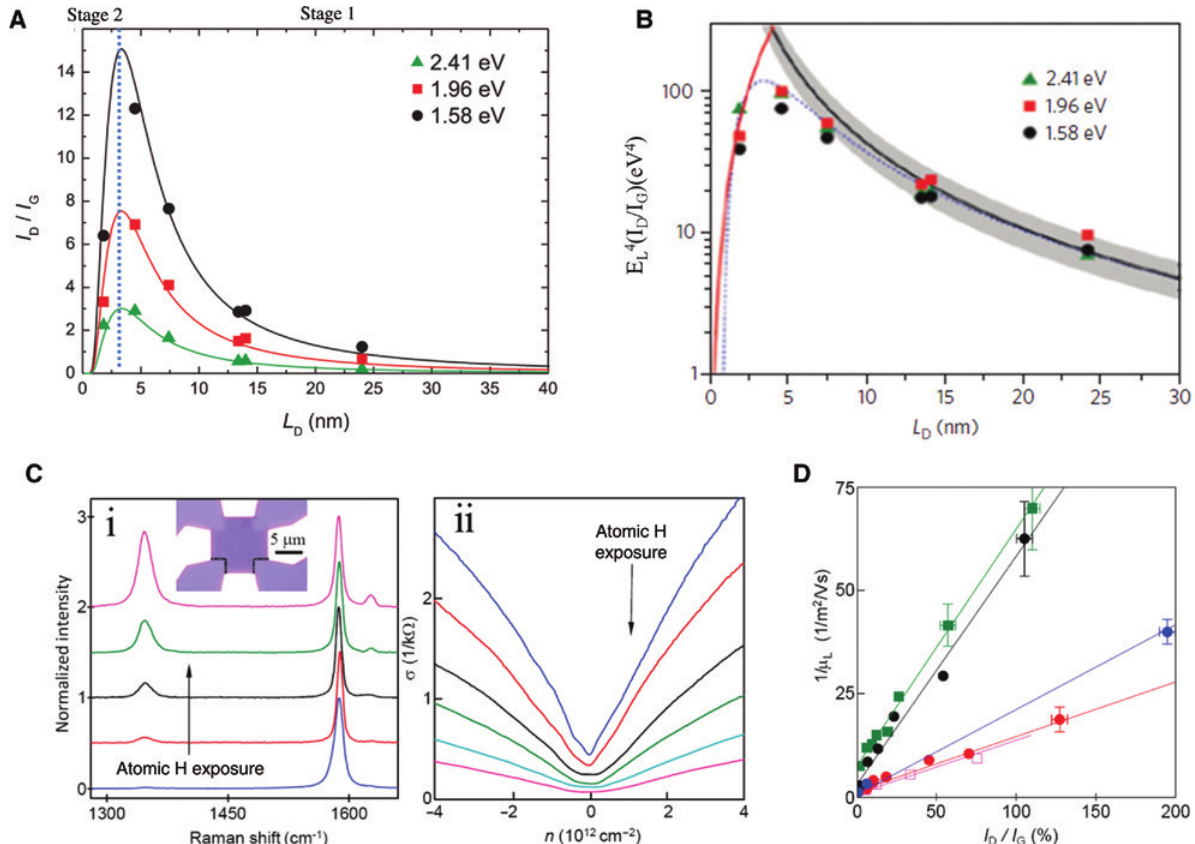
/I with interdefect distances L D G